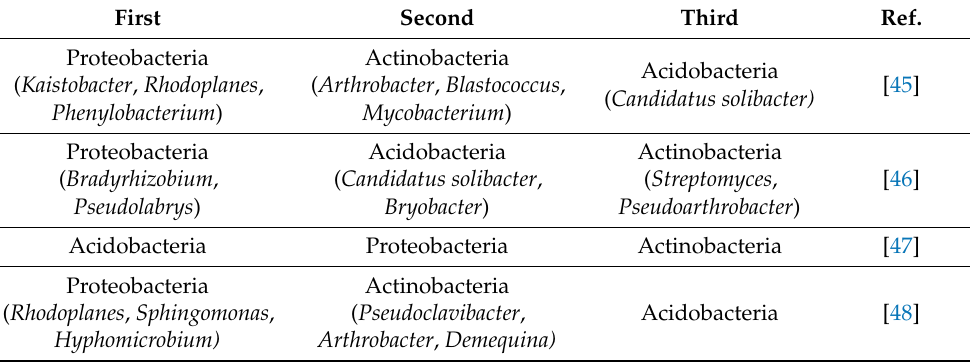
Table 3. Examples of studies of bacterial and fungal rhizobiome diversity in P. quinquefolius . The first most dominant phylum followed by the second and third most dominant phyla are listed with common genera within each phylum in parentheses when